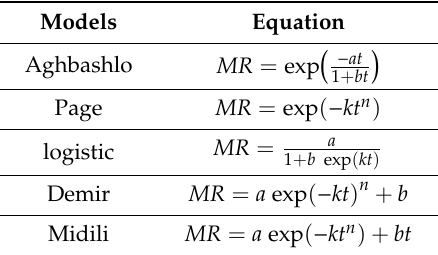
Table 1. Mathematical empirical models